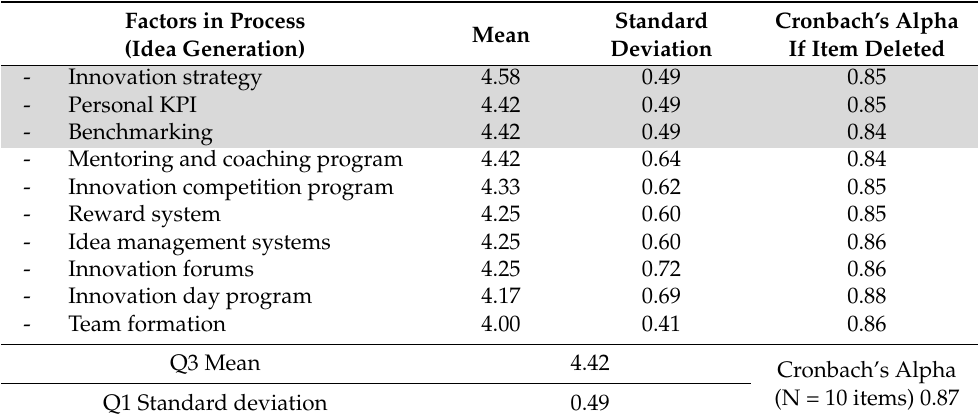
Table 4. Calculation of Q3 mean and Q1 standard deviation of idea generation process indicator factors.